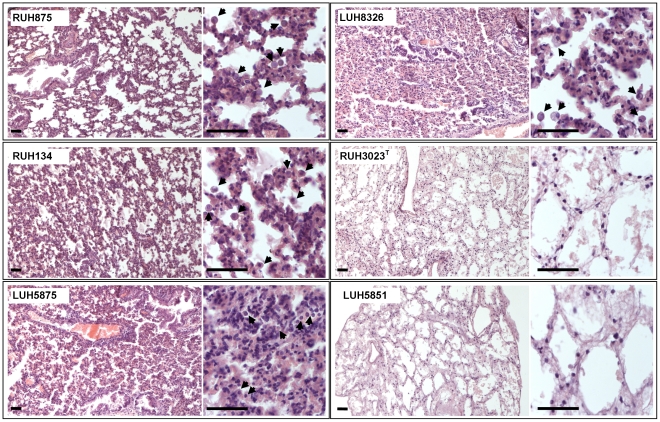
Light micrographs of lungs of mice infected with Acinetobacter.Sections of the lungs of mice at 1 day after infection with A. baumannii clone I strain RUH875, clone II strains RUH134, clone III strain LUH5875, sporadic strain LUH8326, type strain RUH3023T or A. junii strain LUH5851, stained with haematoxylin-eosin. Arrows indicate inflammatory cell infiltrates. Bars, 50 µm.